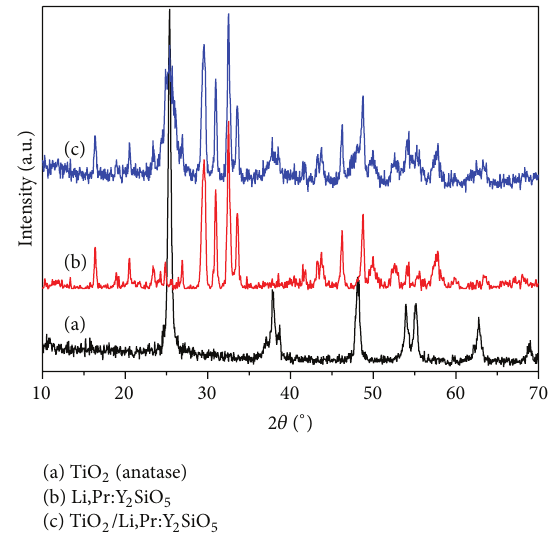
Figure 3: XRD patterns of samples. (a) Commercial anatase TiO 2 ; (b) Li,Pr:Y 2 SiO 5 ; (c) TiO 2 /Li,Pr:Y 2 SiO 5